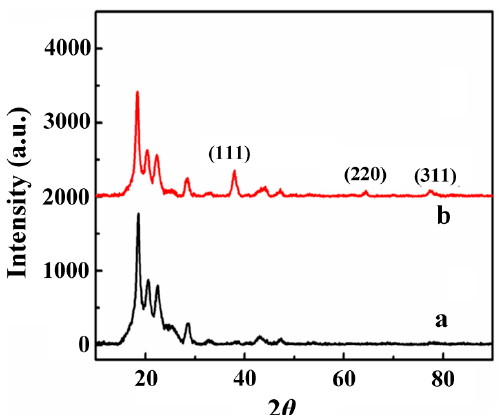
Figure 2. A glassy carbon electrode before ( a ) and after ( b ) being modified with gold nanoparticles was characterized with X-ray diffraction.